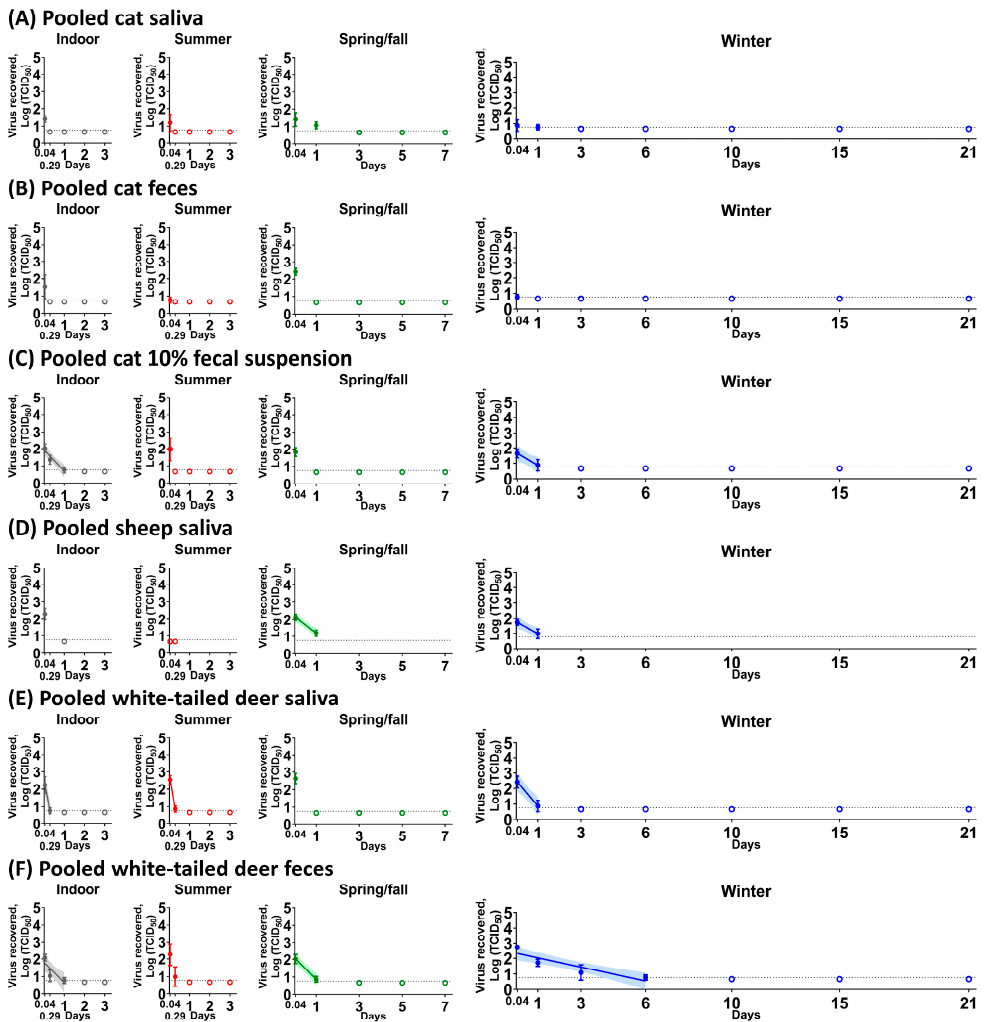
Figure 1. SARS-CoV-2 stability in pooled cat saliva ( A ), pooled cat feces ( B ), pooled cat 10% fecal suspension ( C ), pooled sheep saliva ( D ), pooled white-tailed deer saliva ( E ), and pooled white-tailed deer feces ( F ). Each biological fluid was spiked with 5 × 10 4 TCID 50 of SARS-CoV-2 and incubated under indoor (gray), summer (red), spring/fall (green), and winter (blue) conditions. At each time point, the virus was recovered and titrated on Vero E6 cells. The simple linear regression was estimated when the infectious virus was at least present at two different time points. The virus titer is represented as the mean and standard deviation of log transformed TCID 50 titers (colored circle), whereas empty colored circles represent negatives in triplicate. Colored lines and their shaded areas represent a best-fit line and 95% confidence interval of the simple linear regression. On the x-axis, 0.04 and 0.29 days are equal to 1 and 7 h, respectively. Due to insufficient volume of pooled sheep saliva ( D ), the virus stability was observed at two time points. The best-fit line was not shown in pooled cat saliva under spring/fall and winter conditions ( A ), and pooled white-tailed deer feces under summer conditions ( F ) because the slope of simple linear regression was not significantly different than